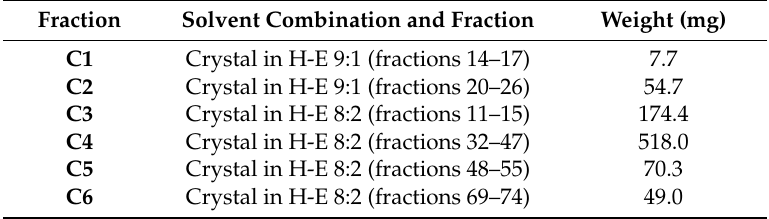
Table 3. Fractions isolated from Piper methysticum root by column